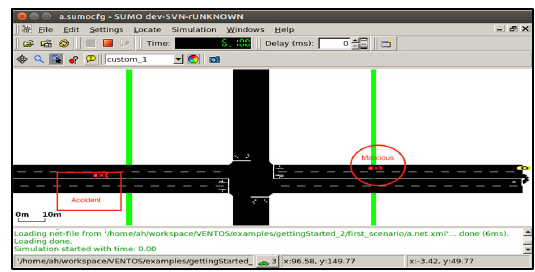
Fig. 11. Scenario 2: A Malicious Vehicle Communicates with the RSU and other Vehicles to Change Them